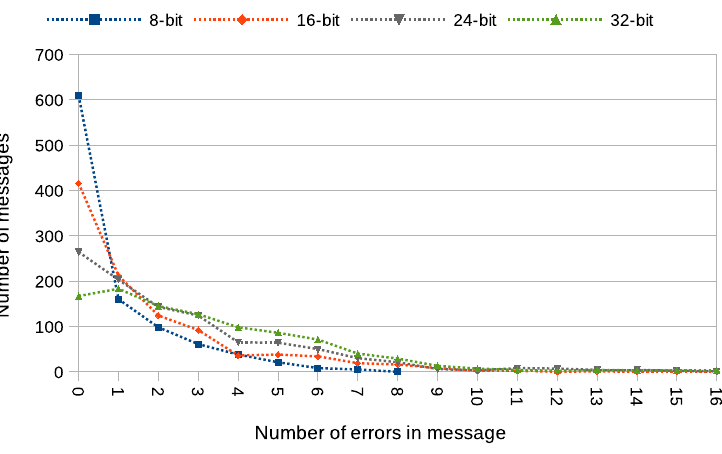
Figure 16. Numbers of messages received with different number of error bits (IEEE 802.11n;